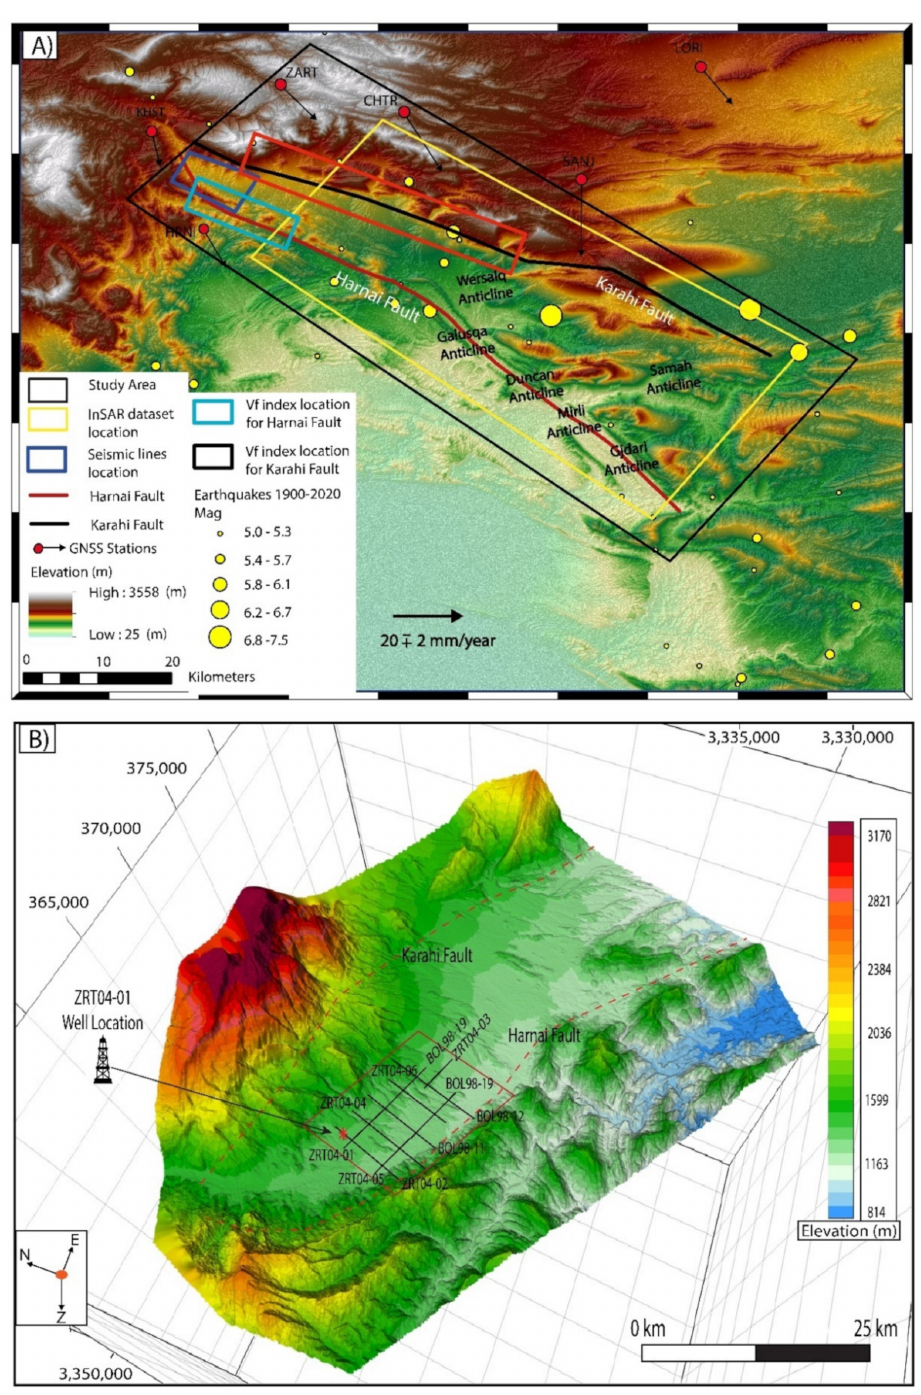
Figure 2. ( A ) Thirty-meter resolution SRTM digital elevation model and hillshade of the study area. The yellow rectangle shows the location of the Sentinel 1 ascending and descending track geometry used in InSAR processing; the blue frame shows the location of the seismic lines. The red and cyan rectangular areas represent Vf index locations. The yellow circles illustrate the earthquake of magnitude 5 or above. Solid arrows indicate the GNSS velocity vector obtained from Szeliga et al. [13], showing south–southeastern movement across Harnai and Karahi Fault. All stations movement are relative to the stable Indian plate as defined in Altamimi et al. [28] and are plotted using a Web-Mercator projection. The GNSS station SANJ across the Karahi Fault has a movement rate of ~20 mm/year, while station HRNI across the Harnai Fault has a movement rate of ~10 mm/year [14]. ( B ) Three-dimensional perspective view of the 30 m high-resolution digital elevation model (SRTM) showing the location of the seismic lines with